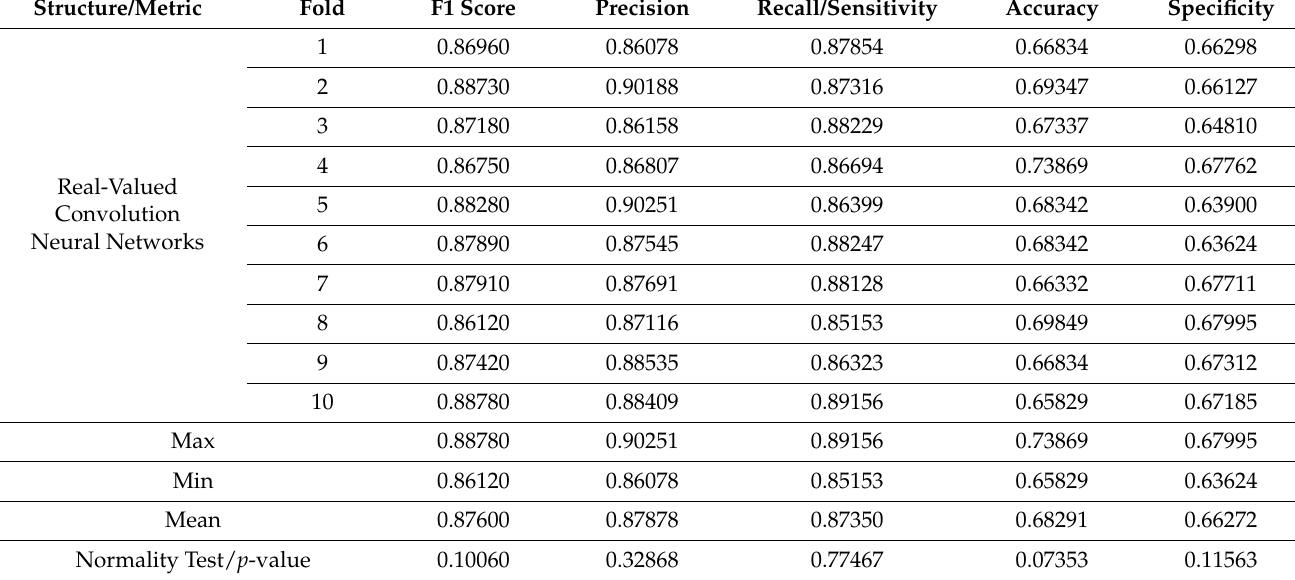
Table 7. Results obtained with the real-valued convolution network studied for the ISIC2017 dataset.